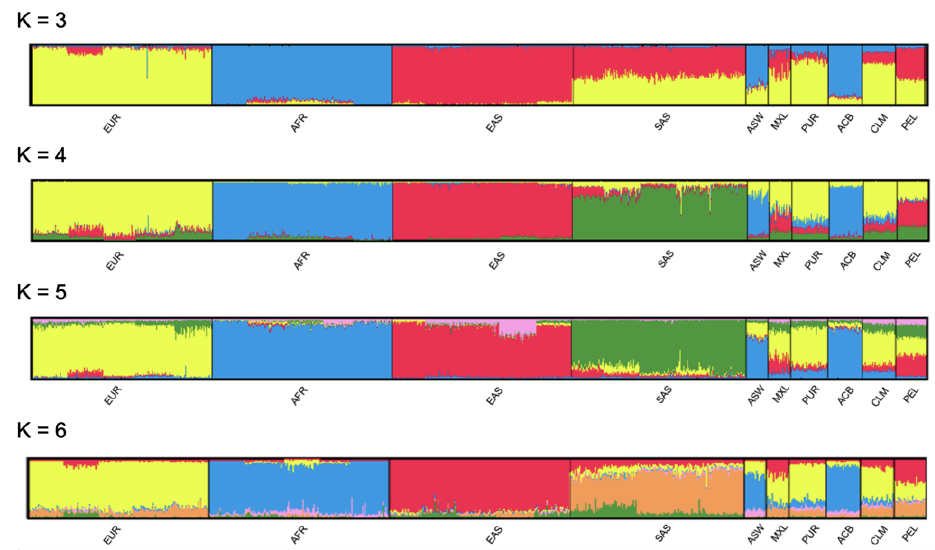
Figure 2. STRUCTURE analysis based on autosomal STR data obtained from the 26 populations included in the 1000 Genomes Project. Five sets of 100 independent runs, with the number of clusters ranging from 3 to 6, were conducted. Each bar plot depicts the results obtained from the run with the largest LnP (D) for the given k .